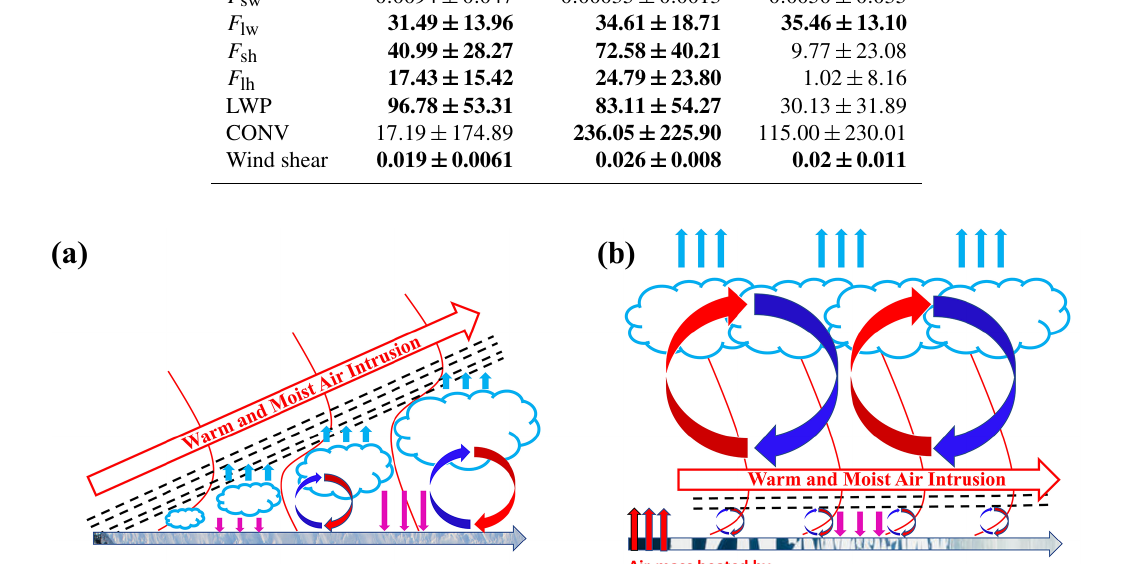
Table 3. Averaged F sh , F lh , F sw , F lw , LWP (from bottom to h t category TBL and category RAD. Statistically significant positive values are in bold.